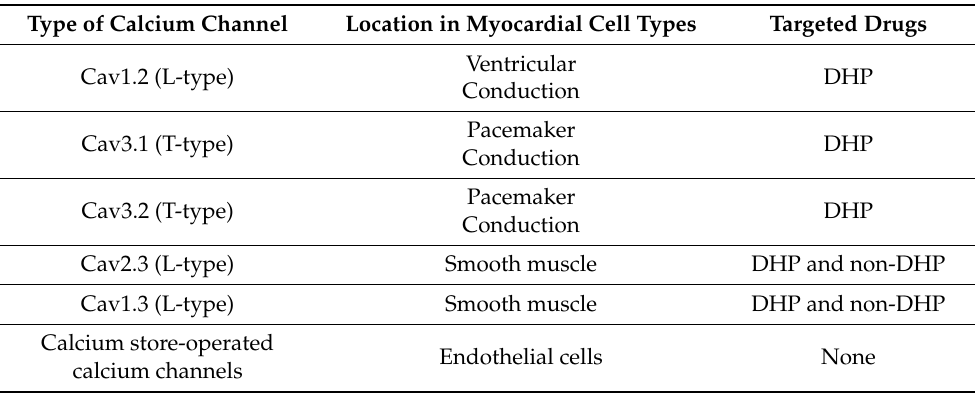
Table 2. Chart represents types of calcium channels, their location in the heart and the class of drugs they are targeted